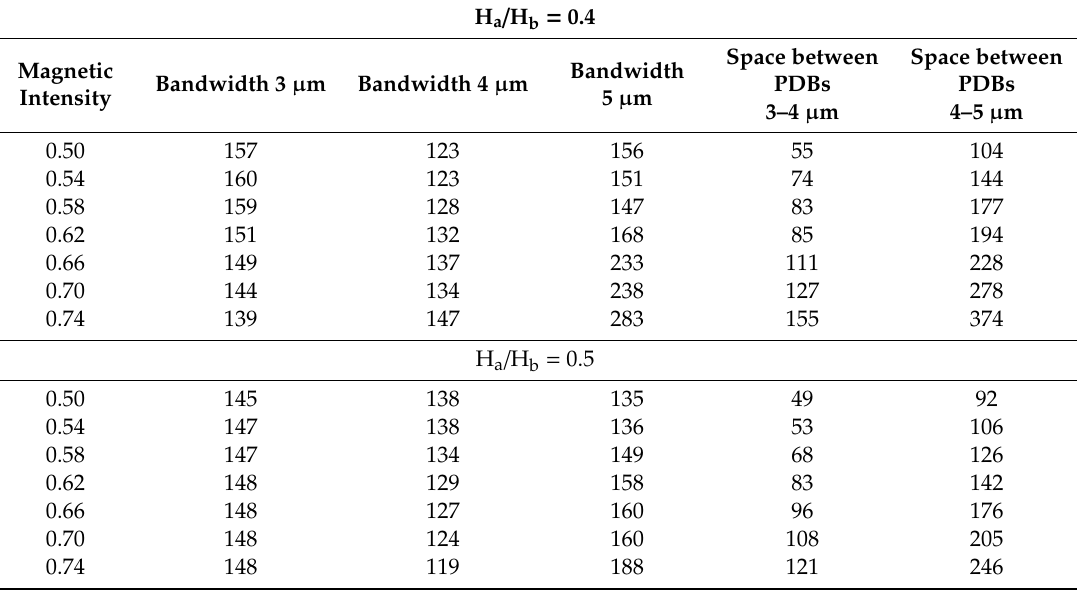
Table 2. Bandwidths and spaces between